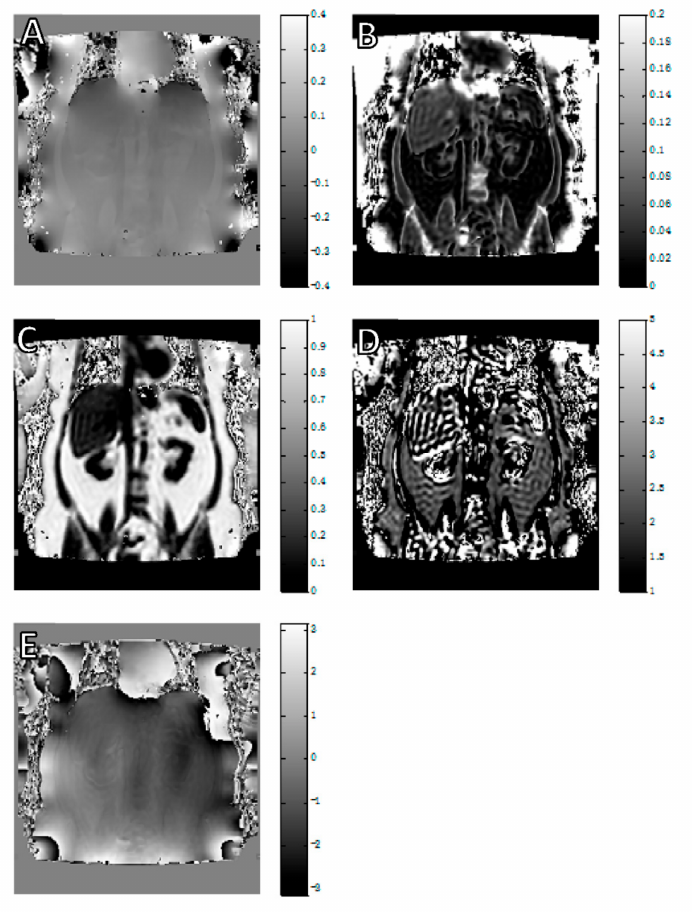
Figure 2. Typical fitted results for the coronal slice in Figure 1: ( A ) B0 in kHz, ( B ) R2* in s − 1 , ( C ) fat fraction, ( D ) NDB and ( E ) initial phase in